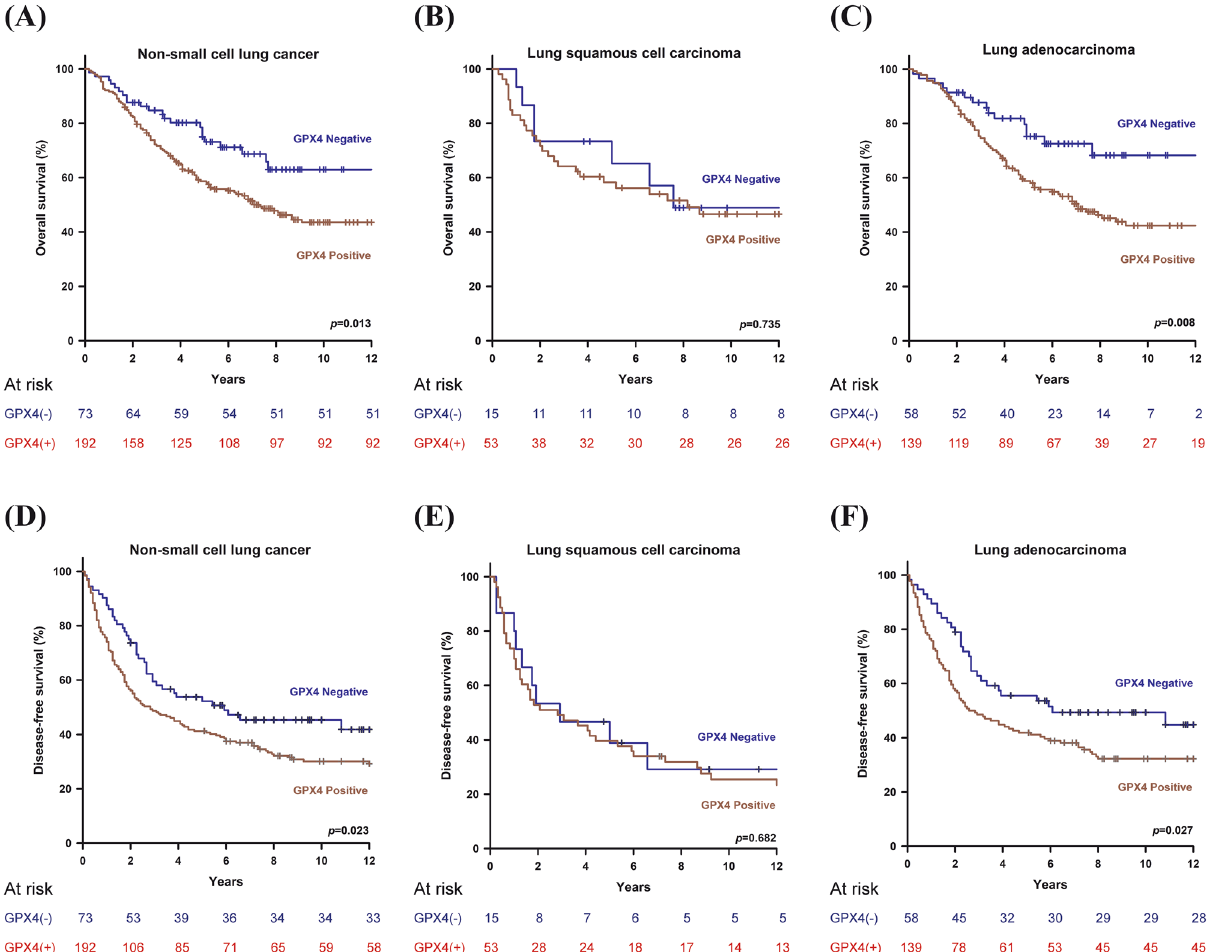
Figure 3. Glutathione peroxidase 4 (GPX4) expression with a 5% cutoff value was significantly associated with OS and DFS in patients with resected non-small cell lung cancer ( A and D , log rank p = 0.013 and 0.023, respectively). In patients with resected lung squamous cell carcinoma, survival analysis showed that with or without GPX4 expression they had similar survival outcomes ( B and E , log rank p = 0.735 and 0.682, respectively). However, in patients with resected lung adenocarcinoma, GPX4 expression had a significantly worse OS and DFS than those with negative GPX4 expression ( C and F , log rank p = 0.008 and 0.027,